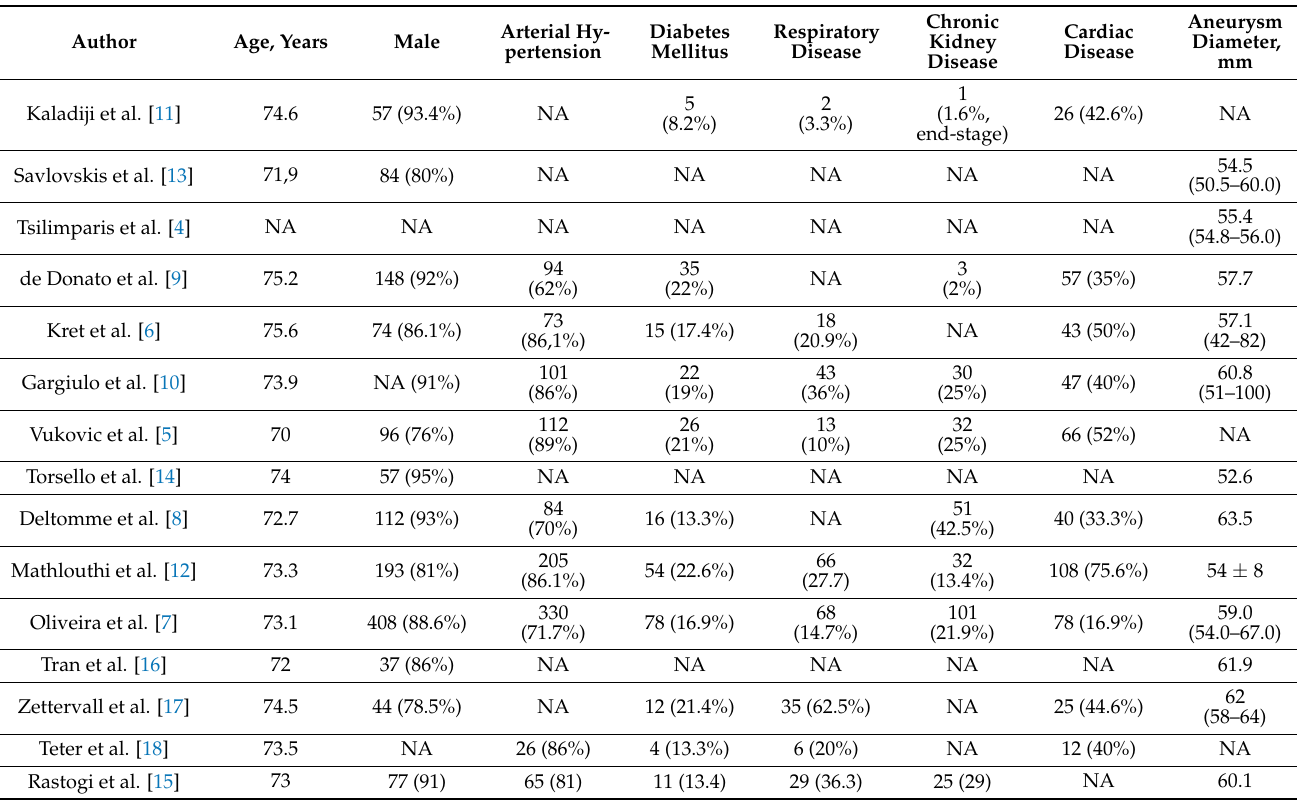
Table 2. Patients characteristics of the included